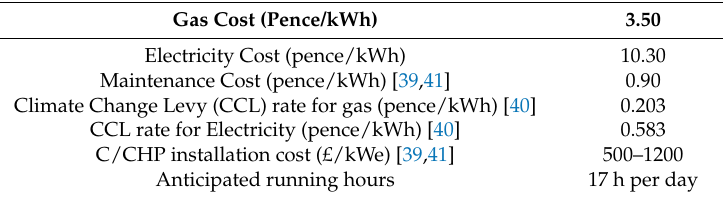
Table 2. Summary of financial assumptions.